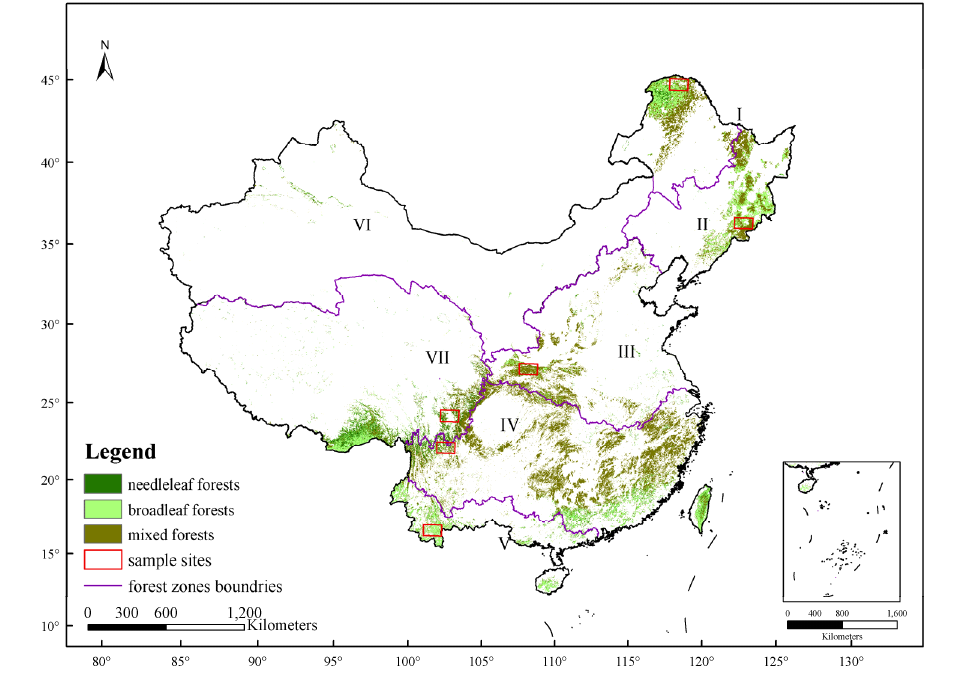
Figure 1. Seven forest zones in China: Red boxes are the field sample sites. (I = cold temperate zone; II = temperate zone; III = warm temperate zone; IV = subtropical zone; V = tropical zone; VI = Neimeng-Xinjiang arid zone; and VII = Qinghai-Xizang plateau alpine zone). Precipitation decreases from the coast to the inland areas. Three vegetation regions, namely forests, steppes, and deserts, correspond to moist, semi-arid, and arid climates, respectively [50]. According to Chinese vegetation geography [49,51] and geographic characteristics of forests, Chinese forests have been divided into five forest zones (Figure 1): Cold temperate zone (I), which is dominated by deciduous needleleaf forests; temperate zone (II), which is characterized by deciduous mixed broadleaf-needleleaf forests; warm temperate zone (III), including China’s largest plain, with secondary broadleaved-mixed forests and intensive agricultural activity; subtropical zone (IV), with large formations of evergreen broadleaf forests (the western region of the subtropical zone is dominated by high mountains